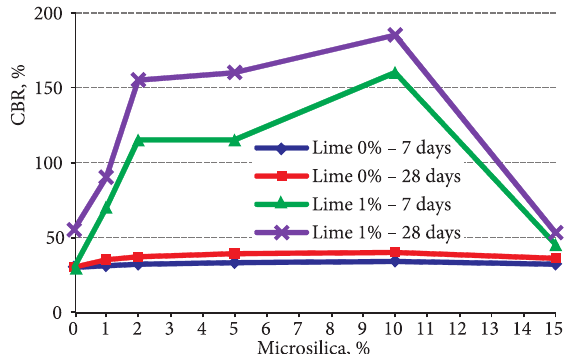
Fig. 4. Effect of adding Microsilica-Lime on CBR with 30 blows for 0% and 1% Lime in dry conditions